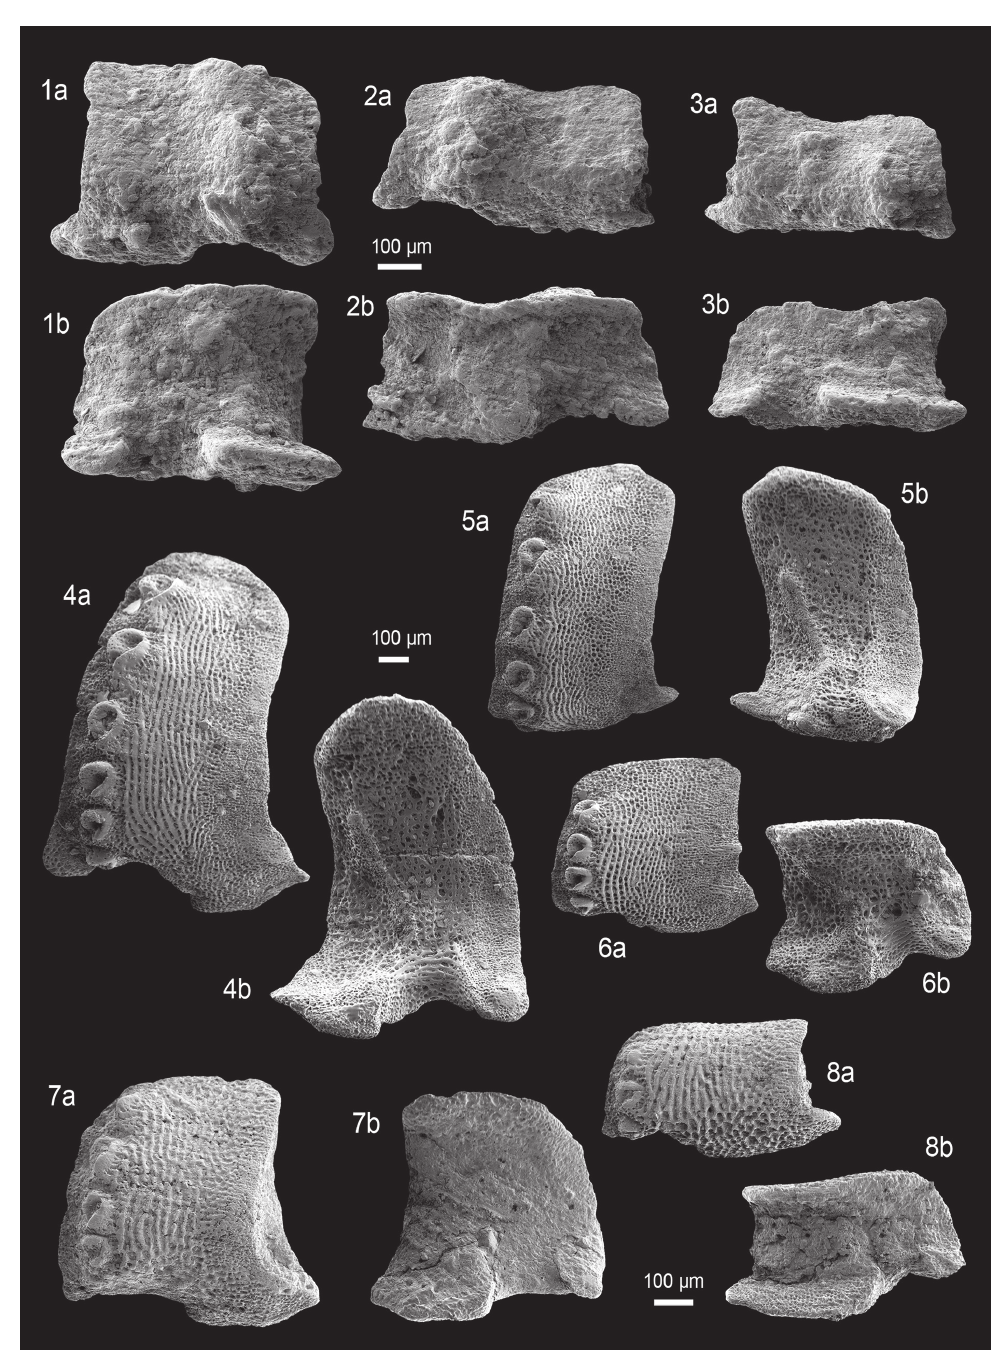
Fig. 7. Fossil lateral arm plates (LAPs) of ophiacanthid brittle stars in external (a) and internal (b) views. 1-3. Lapidaster caeloscopus gen. et sp. nov. from the late Sinemurian to early Pliensbachian (Early Jurassic) of the Glasenbach Gorge, Austria. 1. NHMW 2012/0137/0005 (holotype), proximal LAP. 2. NHMW 2012/0137/0006 (paratype), median LAP. 3. NHMW 2012/0137/0007 (paratype), distal LAP. 4-6. Lapidaster hystricarboris gen. et sp. nov. from the early Pliensbachian (Early Jurassic) of Blockley, Great Britain. 4. GZG.INV.78501 (holotype), proximal LAP. 5. GZG.INV.78502 (paratype), median LAP. 6. GZG.INV.78503 (paratype), distal LAP. 7-8. Lapidaster fasciatus (Kutscher & Villier, 2003) comb. nov. from the middle Toarcian (Early Jurassic) of Le Clapier, France. 7. GZG.INV.78505, proximal LAP. 8. GZG.INV.78506, distal LAP. One common scale bar per species is